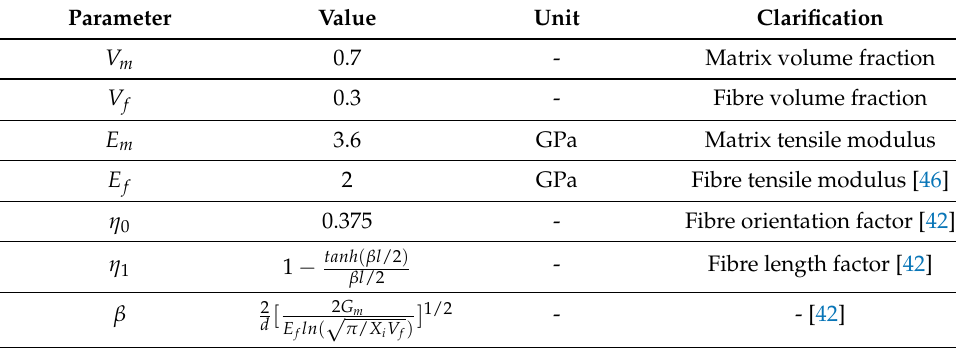
Table 2. Parameters used for the analytical